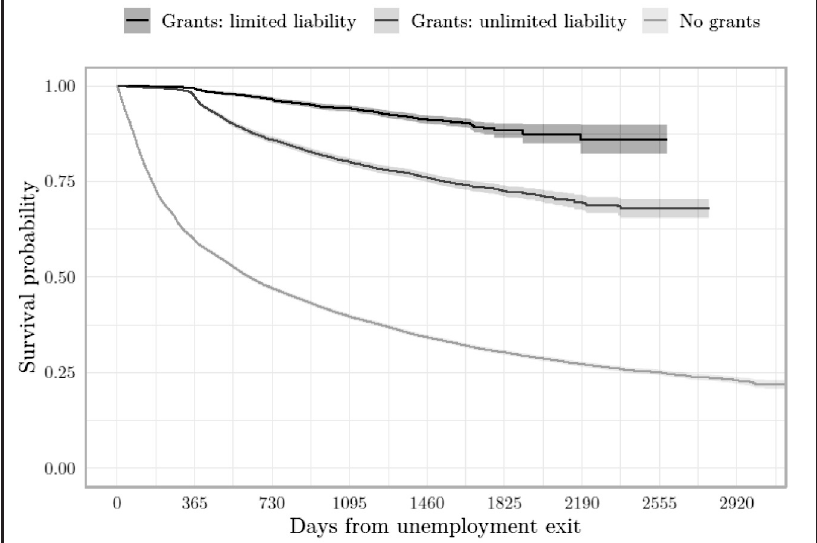
Kaplan–Meier estimate of employment survival by legal